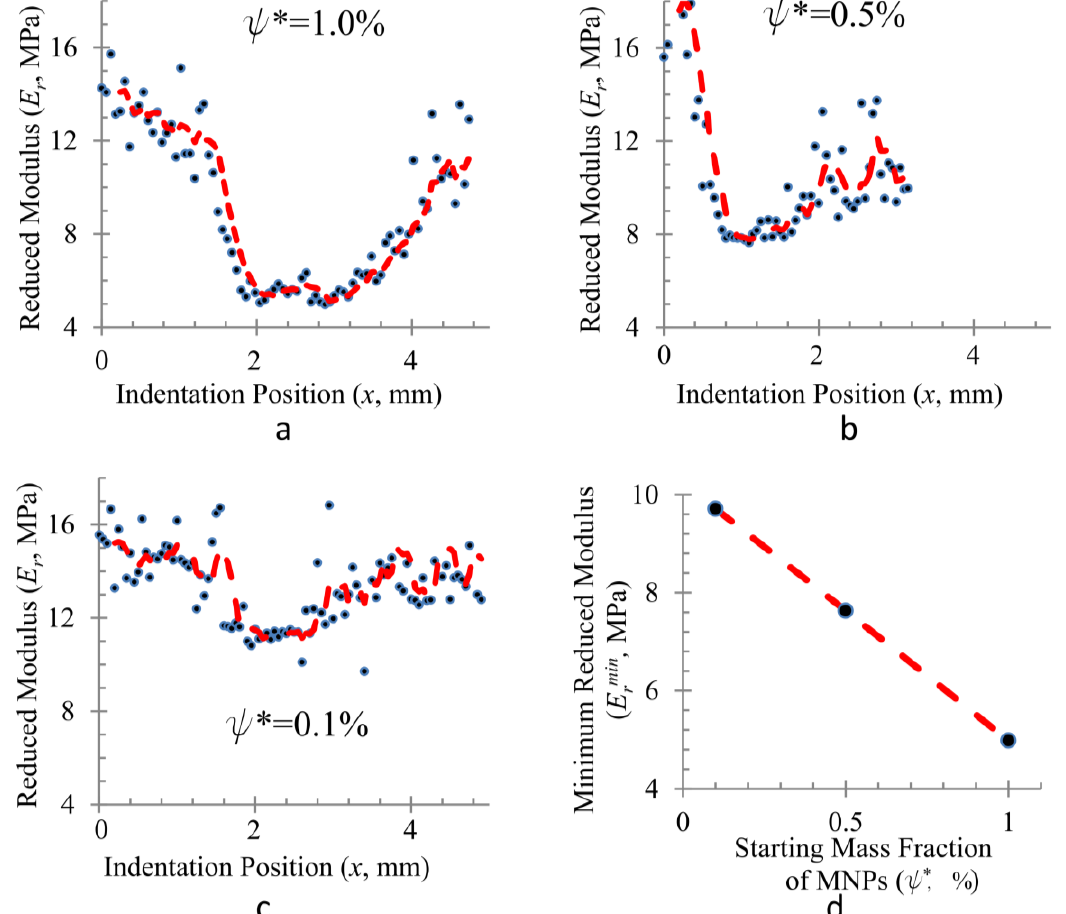
Figure 4. High resolution scan of reduced modulus along a straight line for samples with ( a ) ψ * = 1.0%; ( b ) ψ * = 0.5%; ( c ) ψ * = 0.1% shows that high gradients of the reduced modulus can be formed. The steepest gradient in ( a ) is 12.6 MPa·mm −1 ( R 2 = 0.9623). The general U-shaped profile is seen in all samples. The red dashed line is a 5-point moving average; ( d ) The minimum reduced modulus ( E rmin ) decreases linearly with increasing ψ